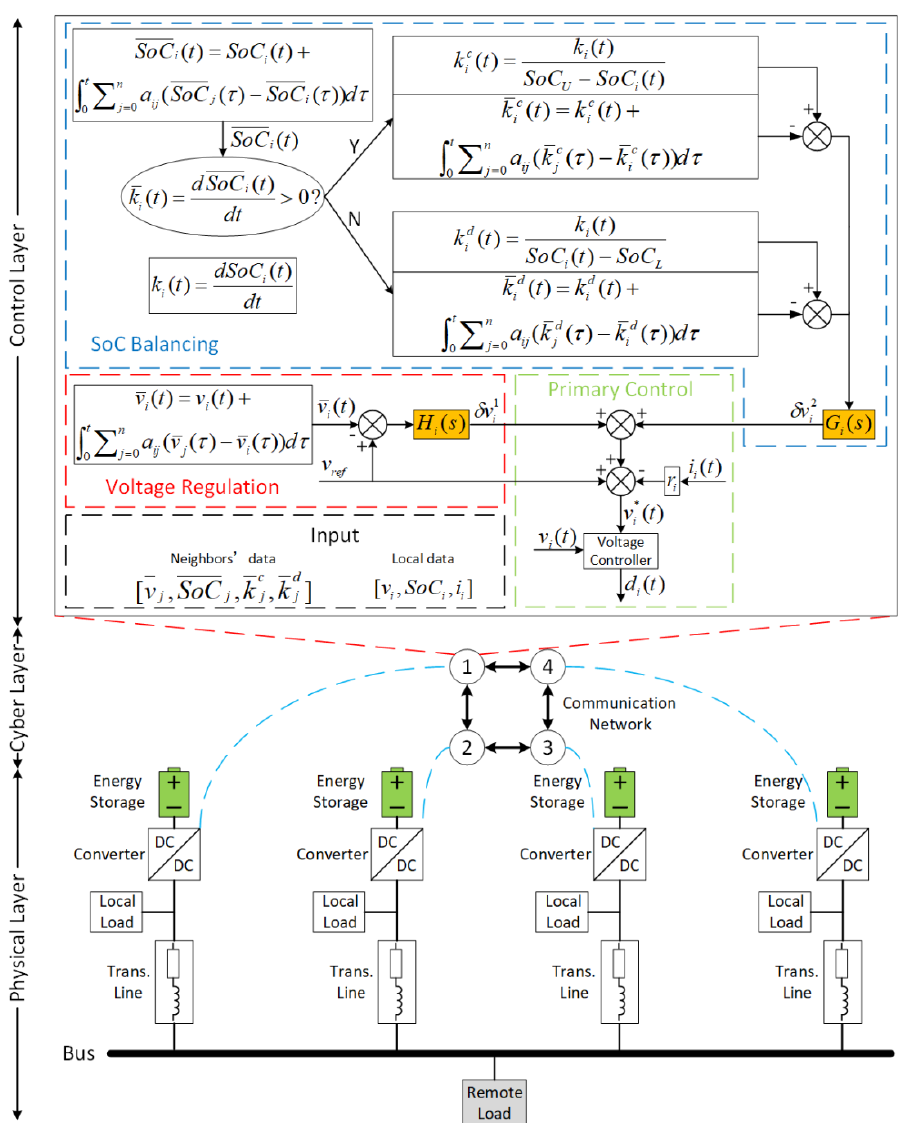
Figure 1. Layout of proposed control for DC microgrid.